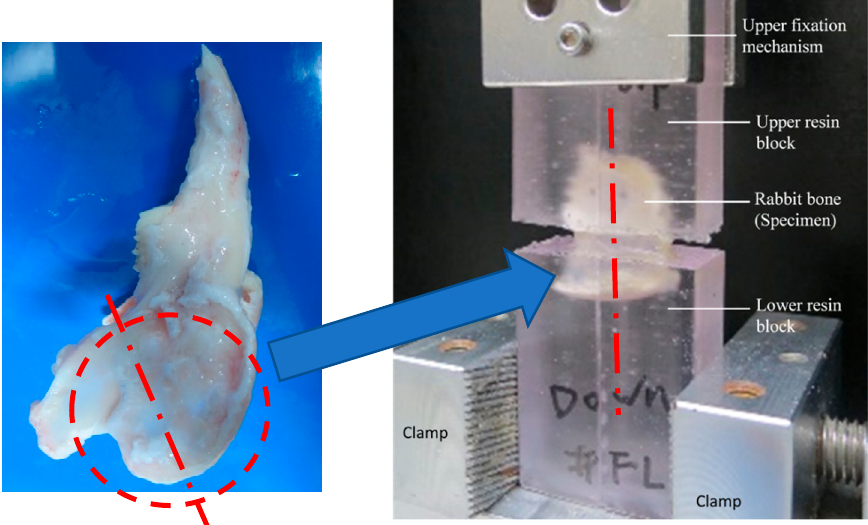
Figure 6. Right: the test specimen (mandibular bone after distraction and intact bone) was clamped and fixed to the materials test system to perform the fracture test. Left: the red circle shows the cutting area and the dotted line is the alignment line with the test machine